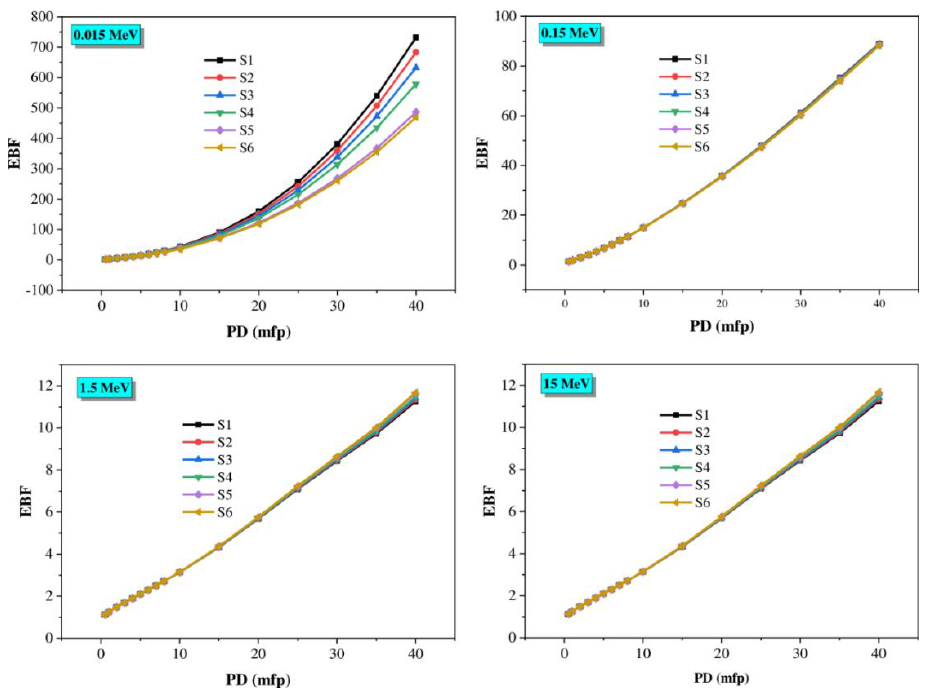
Figure 14. EBF changes against the penetration depth of the glasses at various gamma photon energies (0.015, 0.15, 1.5, and 15 MeV).